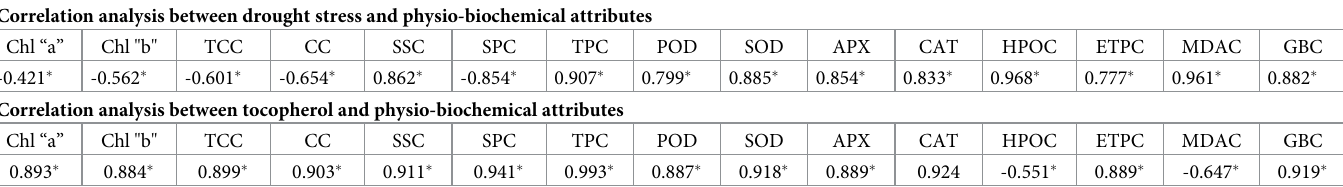
Table 2. Correlation between induced drought stress, α -tocopherol and physio-biochemical attributes of lentil cultivar. Correlation analysis between drought stress and physio-biochemical